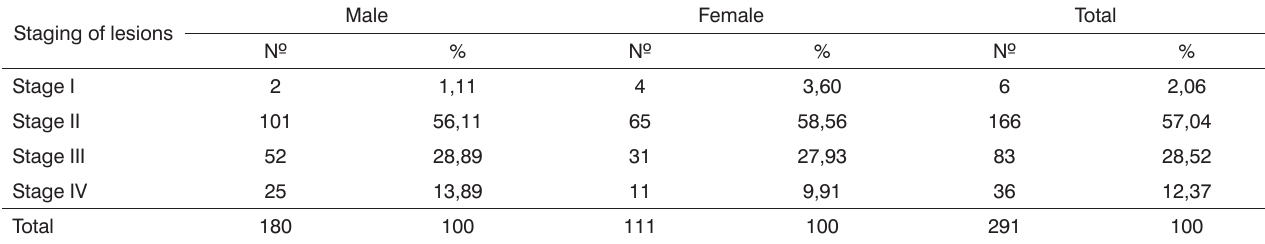
Table 3. Distribution of mouth squamous cell carcinoma patients according to staging of the lesion Maceio-AL, 2000-2006.